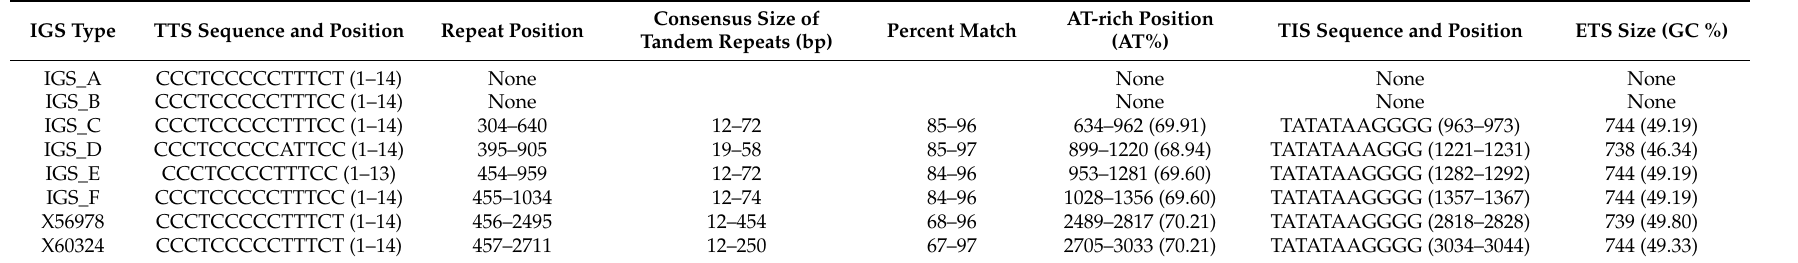
Table 2. Annotation of variation in 45S-IGS